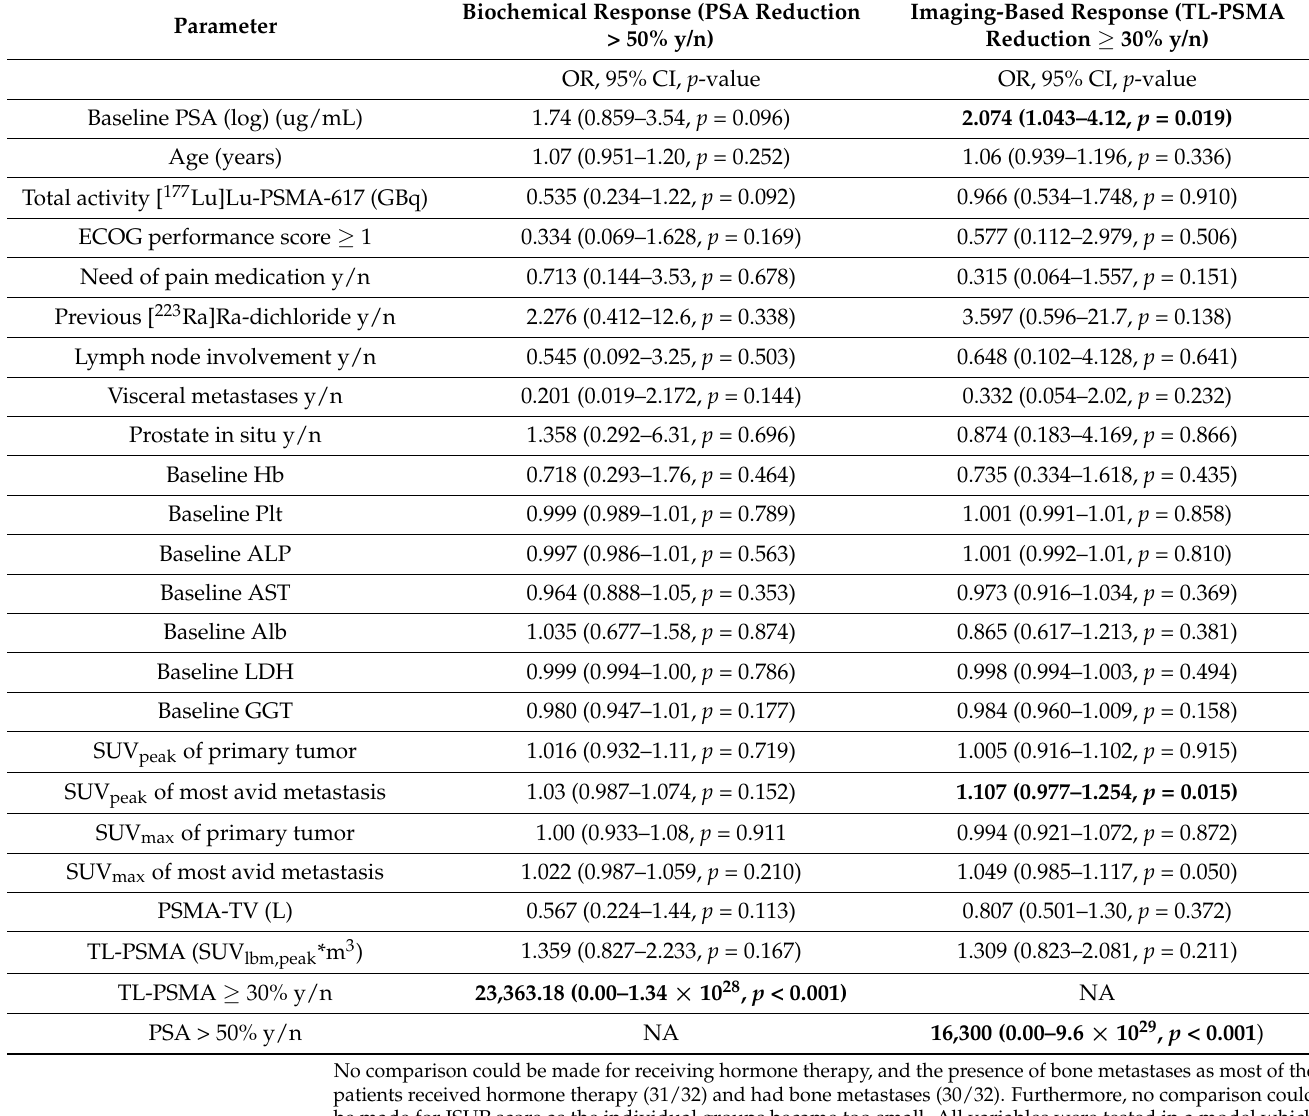
Table 6. Univariate logistic regression analyses of response on the patient-level; significant responses in